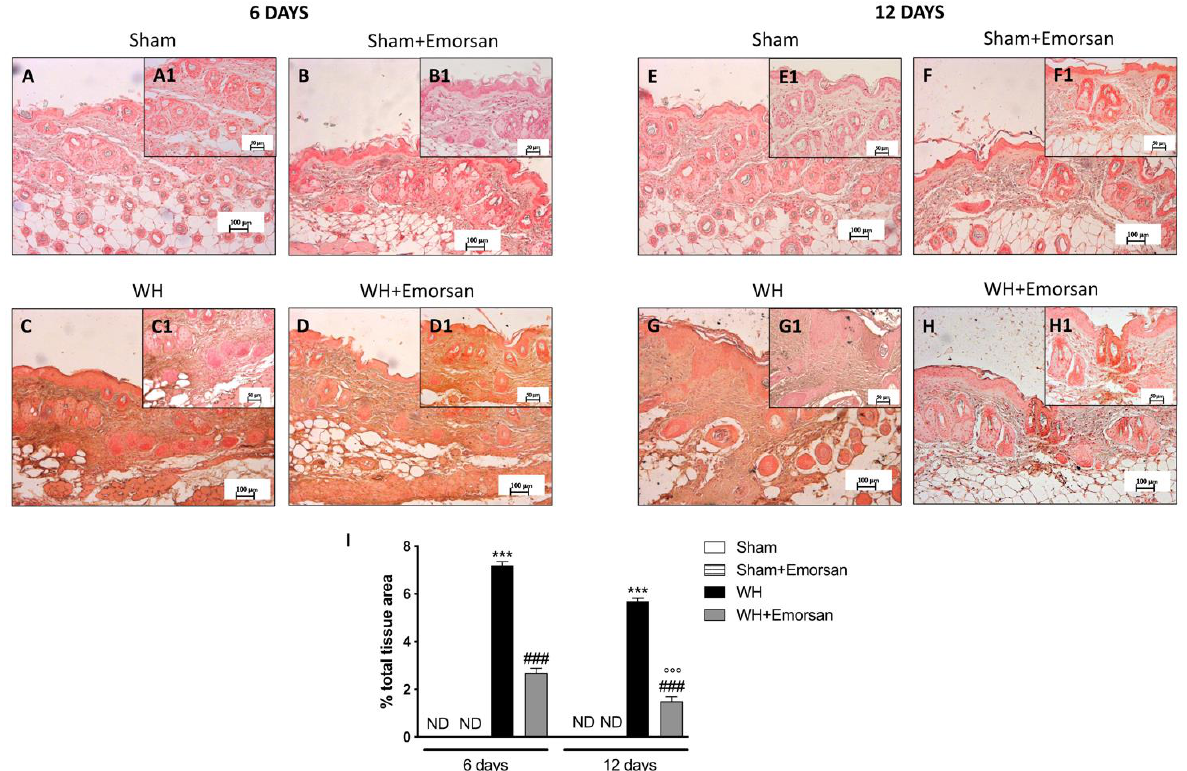
Figure 2. Effect of Emorsan ® Gel treatment on TNF-α expression after WH. Epidermal tissues collected from the WH-vehicle group revealed positive immunostaining for TNF-α ( C , C1 , G , G1 ,score I ), compared to the sham groups ( A , A1 , B , B1 , E , E1 , F , F1 ,score I ). Emorsan ® Gel topical treatment strongly reduced such positive immunostaining at both 6 days ( D , D1 ,score I ) and 12 days ( H , H1 ,score I ) after WH induction. Data are representative of at least three independent experiments. Values are means ± SEM. One-Way ANOVA test. *** p < 0.001 vs. corresponding Sham; ### p < 0.001 vs. corresponding WH; °°° p < 0.001 vs. WH+Emorsan 6 days; ND: not detectable.